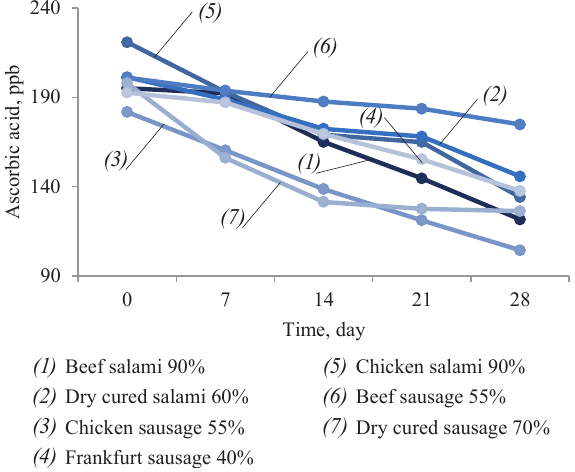
Figure 3 Nitrosamine content (ng/kg of meat) in sausages with different meat content from factory B on days 0, 7, 14, 21, and